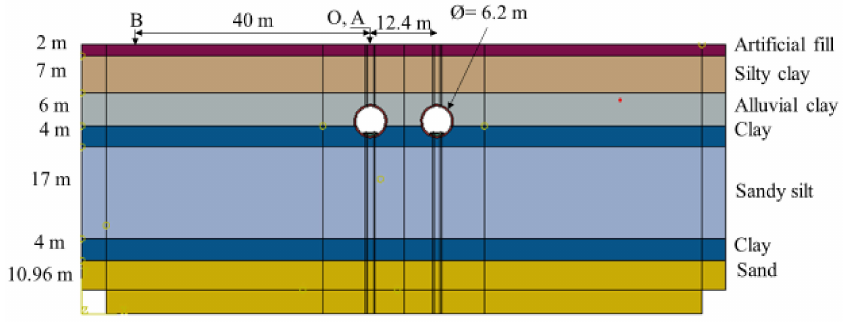
Figure 1. Tunnel description.